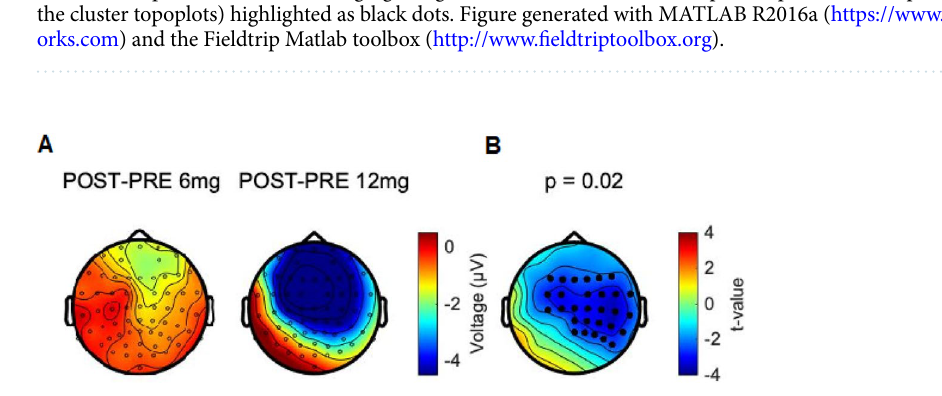
Figure 4. ( A ) Topographical maps of absolute changes (in µV) in power values (Post–Pre) in the P60 TEP under the two different dosages of perampanel (12 mg vs. 6 mg). ( B ) t-value topography of the difference of the two effects obtained with cluster-based statistics. Channels where a statistically significant difference was expressed between (Post–Pre 12 mg) and (Post–Pre 6 mg) P60 are indicated by black dots (p = 0.02). Figure generated with MATLAB R2016a (https:// www. mathw orks. com) and the Fieldtrip Matlab toolbox (http:// www. field tript oolbox.